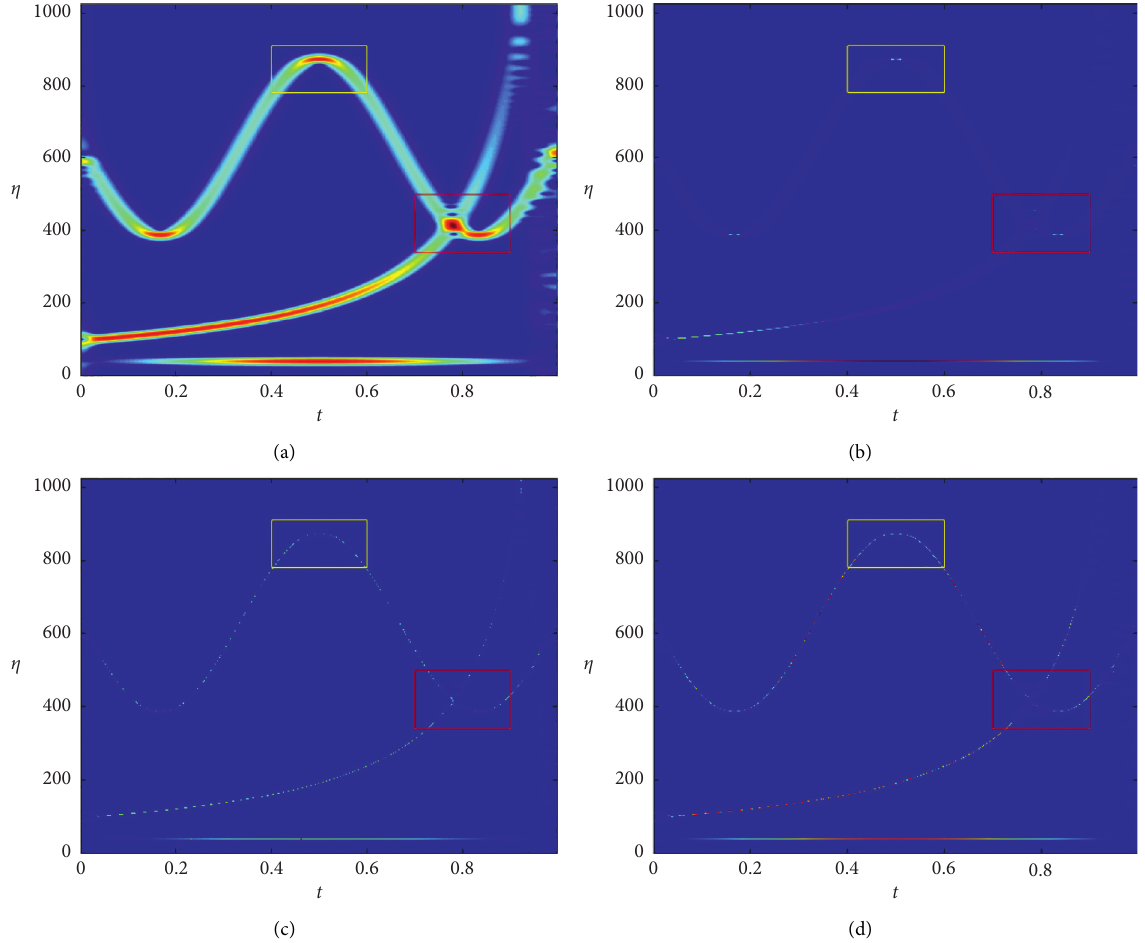
Figure 2: Time-frequency rearrangements (TFRs) obtained by (a) STFT, (b) synchrosqueezing transform (SST), (c) oblique SST (OSST), and (d) vertical SST